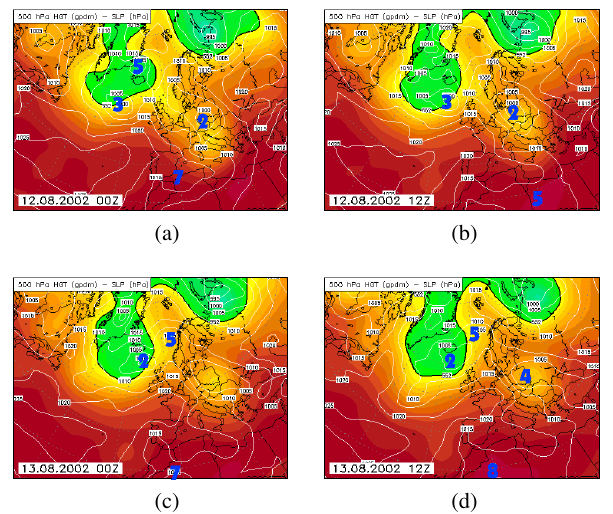
Figure 9. As in Fig. 7, but for 12 and 13 August Figure 9 : As in Fig. 7, but for 12 and 13 August, 2002.